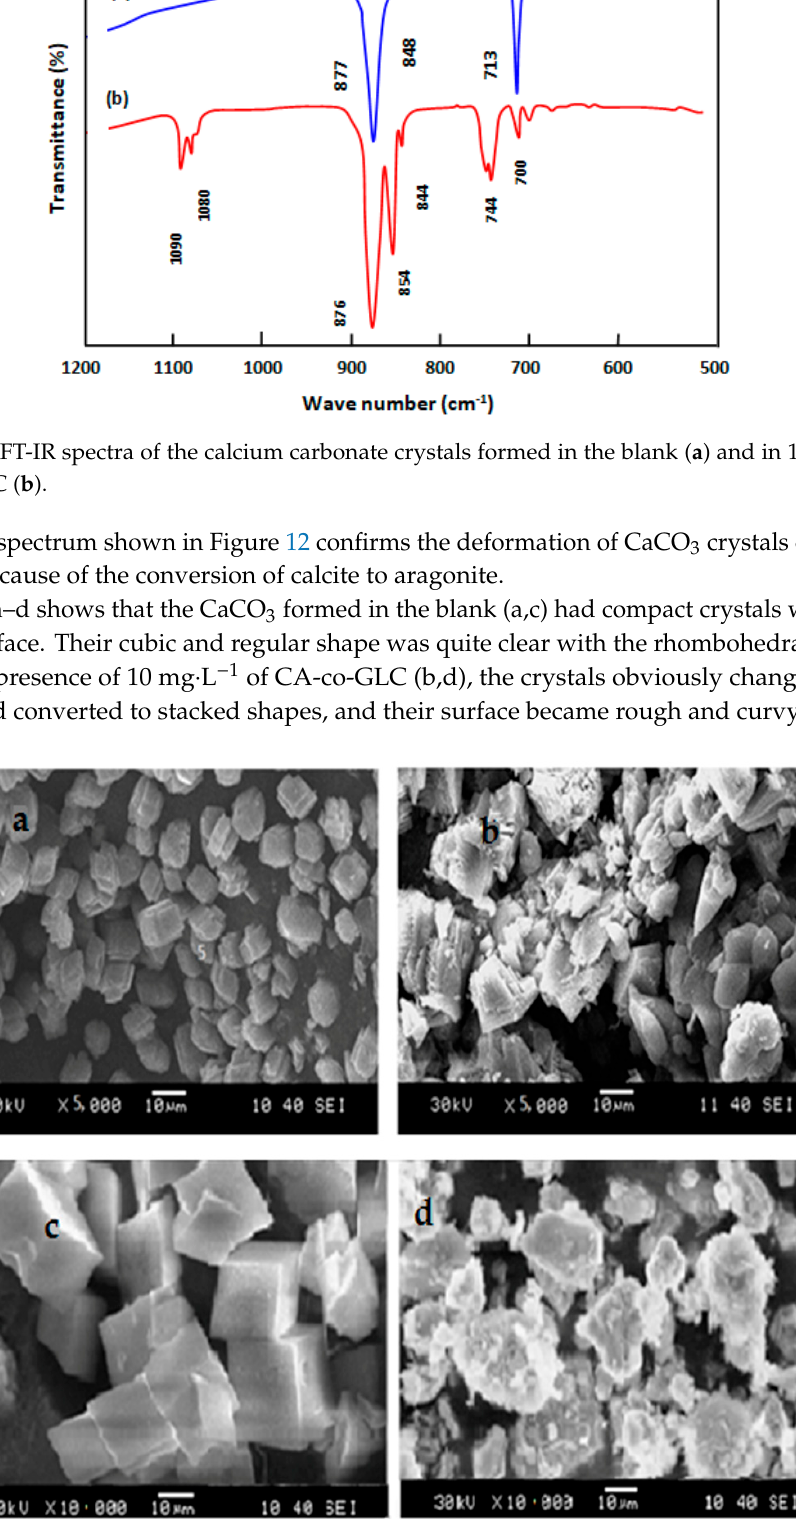
Figure 13. SEM images at different resolutions of the CaCO 3 scale ( a , c ) in the blank solution and ( b , d ) in the presence of CA-co-GLC (Ca 2+ 1000 mg·L − 1 , pH 7.5, T 50 °C).